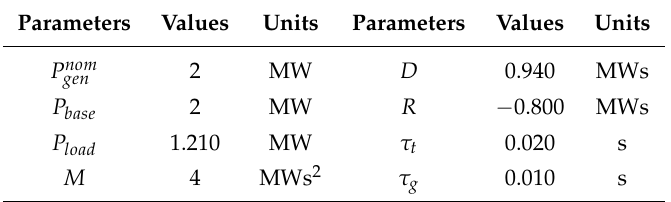
Table 7. Parameters for the synchronous generator model and load